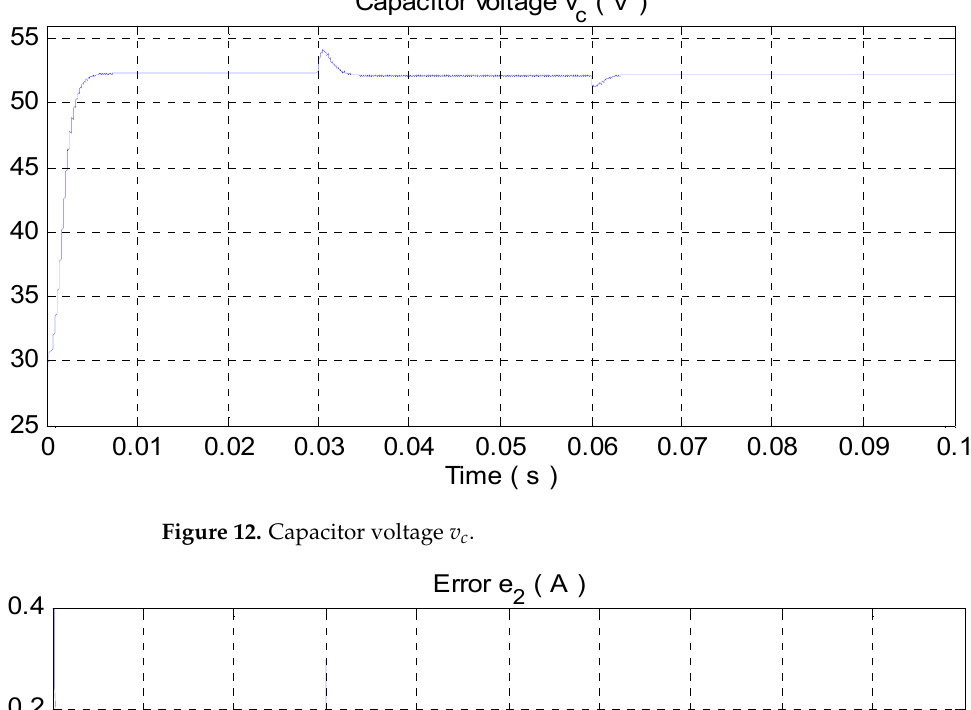
Figure 11. Fuel cell current i fc .